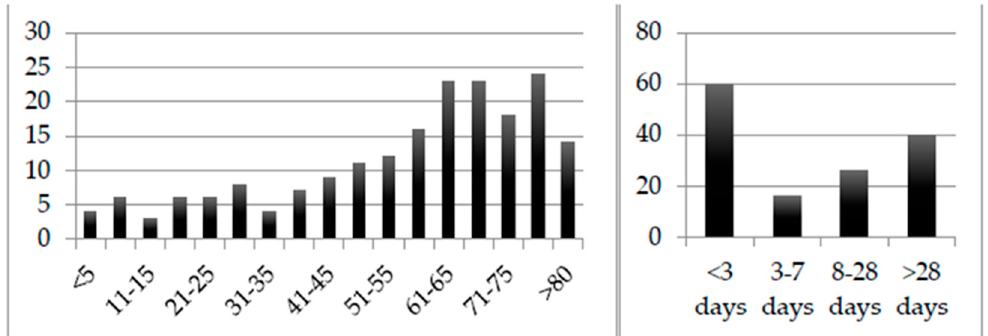
Figure 4 . Number of isolates detected in non-screening specimens grouped by patient age ( left ) and by length of hospital stay previous to detection ( right ).